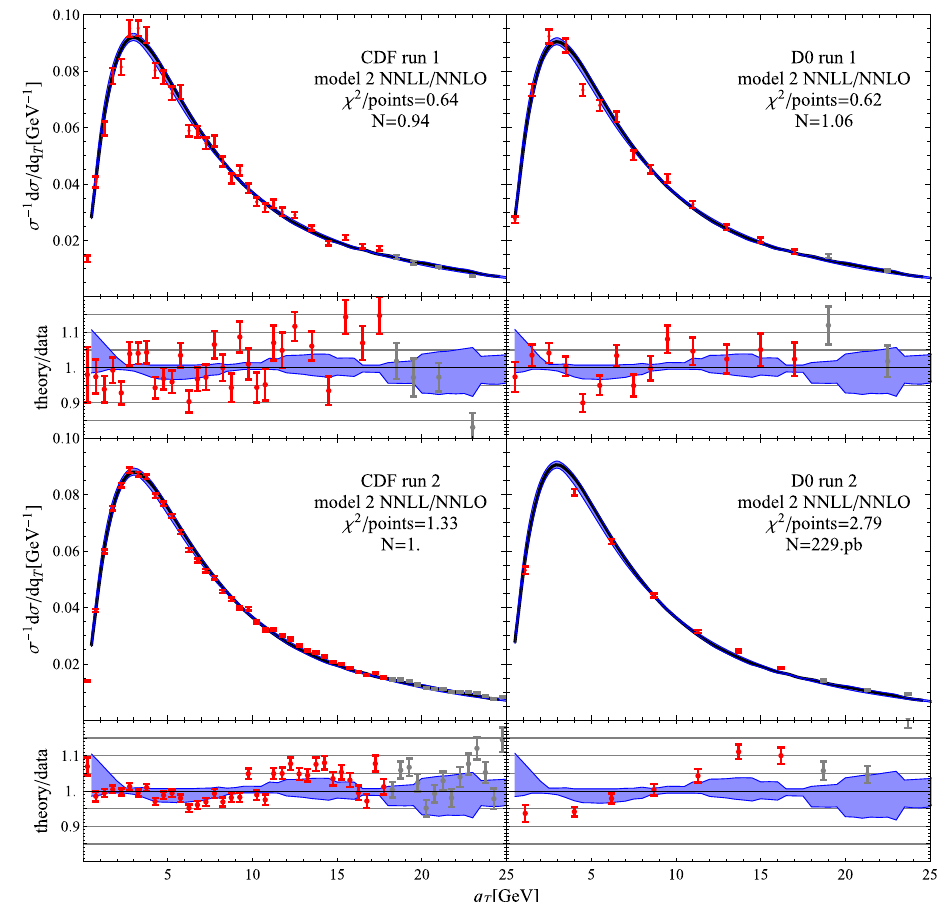
Fig. 10 The comparison of the data for Z-boson production collected at Tevatron experiments (run 1 and run 2) to the fit of model 2 at NNLL/NNLO. Red data points are those which included in the fit (i.e.